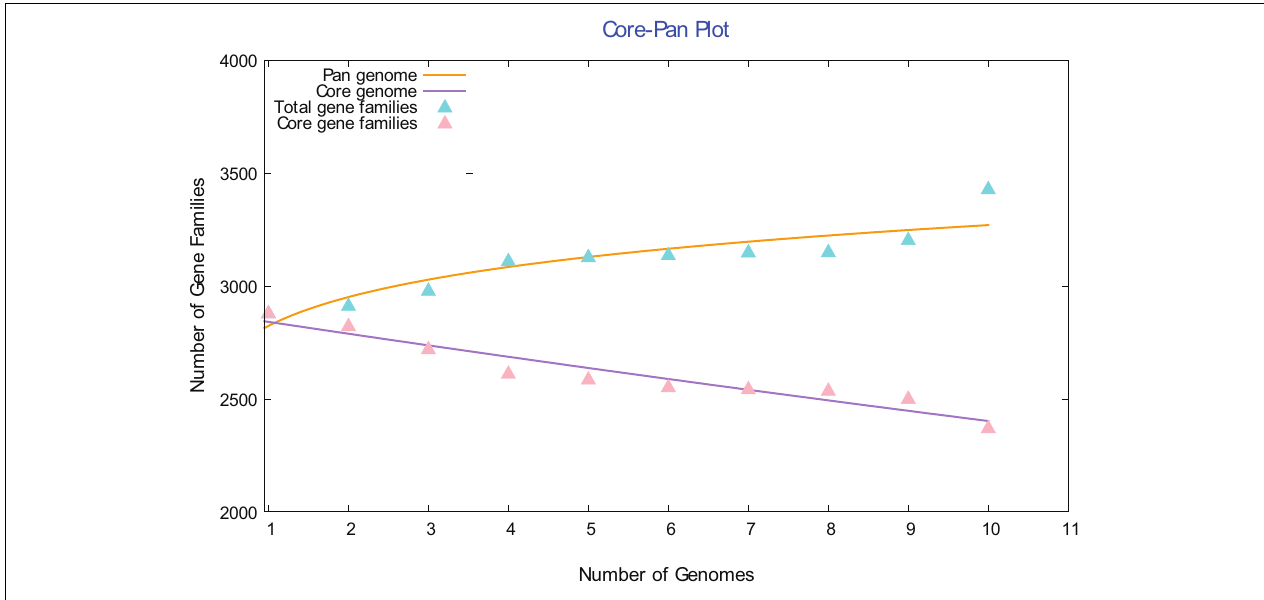
FIGURE 5 | Comparison of the core and pangenome of the genus Chloracidobacterium . The open pangenome character of the Chloracidobacterium spp. strain genomes is illustrated by this core versus pangenome plot. As the number of included genomes increases, the pangenome increases and the conserved core gene families decreases.